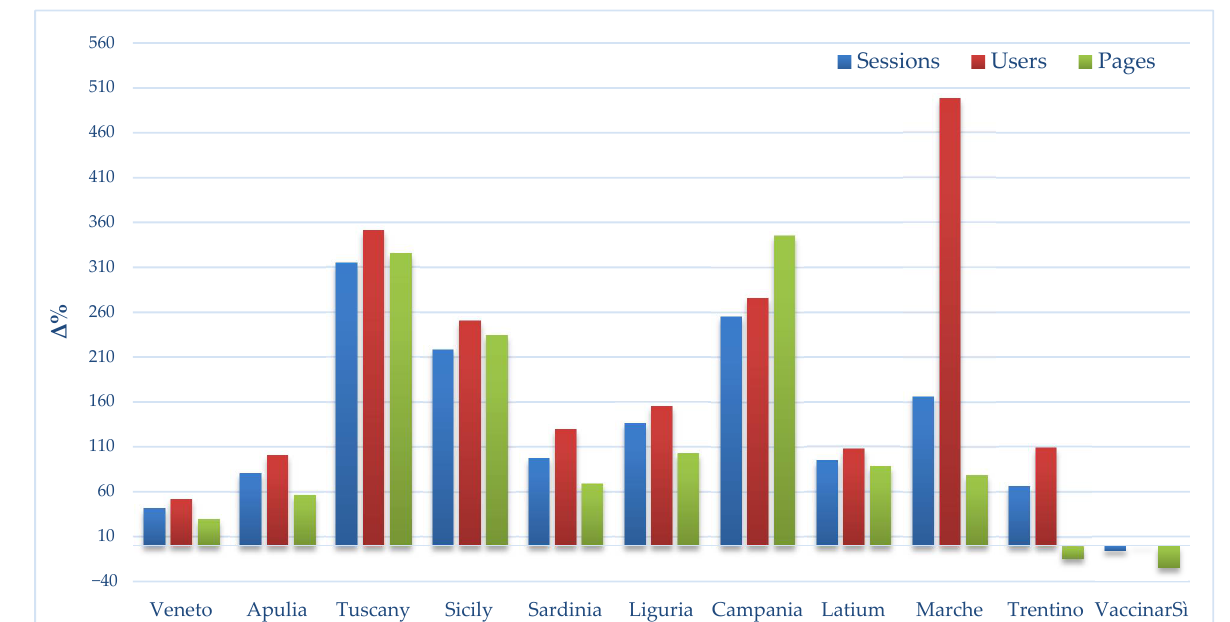
Figure 2. Percentage difference in absolute values of users, sessions and pageviews on network websites in the pre-COVID-19 and COVID-19 eras.